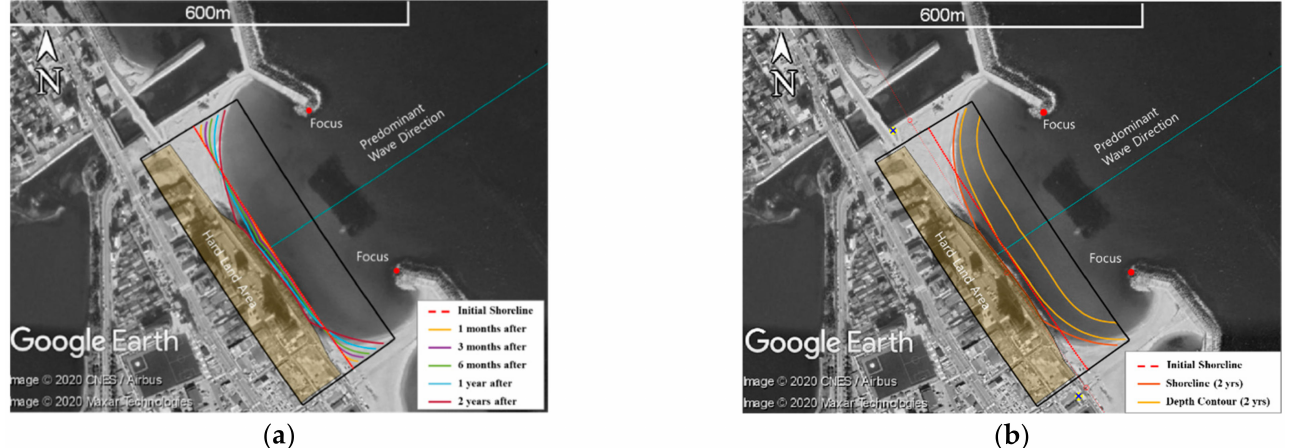
Figure 14. Shoreline change model simulation of change to Yeongrang beach, caused by construction of double headland: ( a ) shoreline change; ( b ) depth contour change (image from Google Earth as at April 2019).